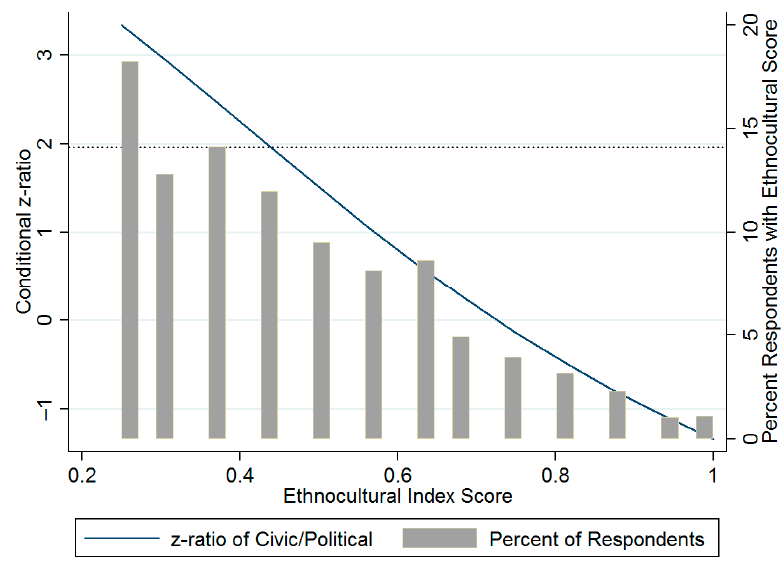
Figure 3. Conditional z-ratio for the civic/political dimension score.